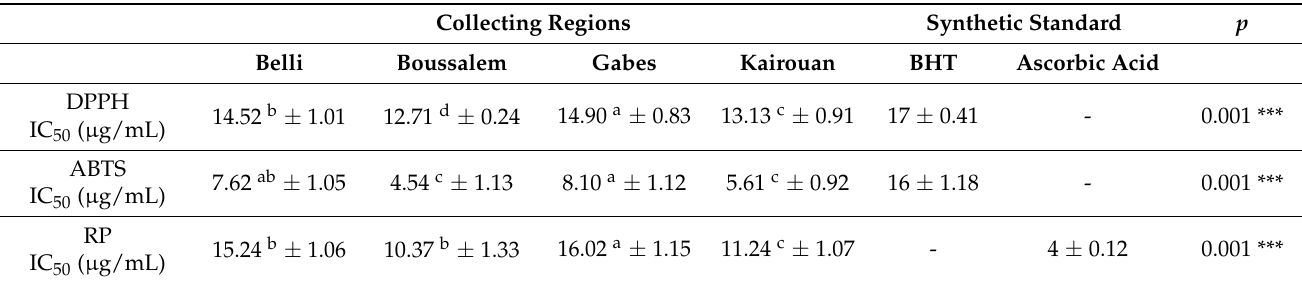
Table 4. Antioxidant properties against DPPH and ABTS radicals and the reducing power (RP) of methanolic lemon verbena extract.